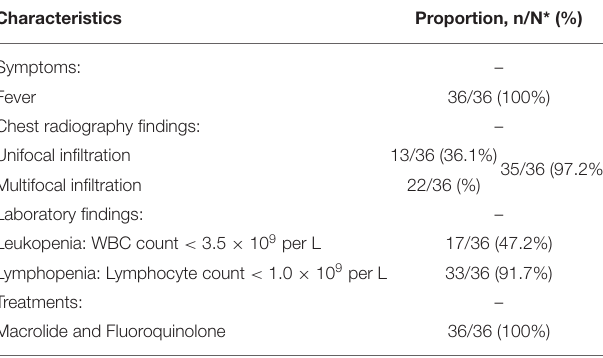
TABLE 2 | Characteristics summary of probable Severe Acute Respiratory Syndrome (SARS) patients according to the surveillance guideline for pneumonia with uncertain etiologies, from April 27 to May 24, 2003, in Taiwan (